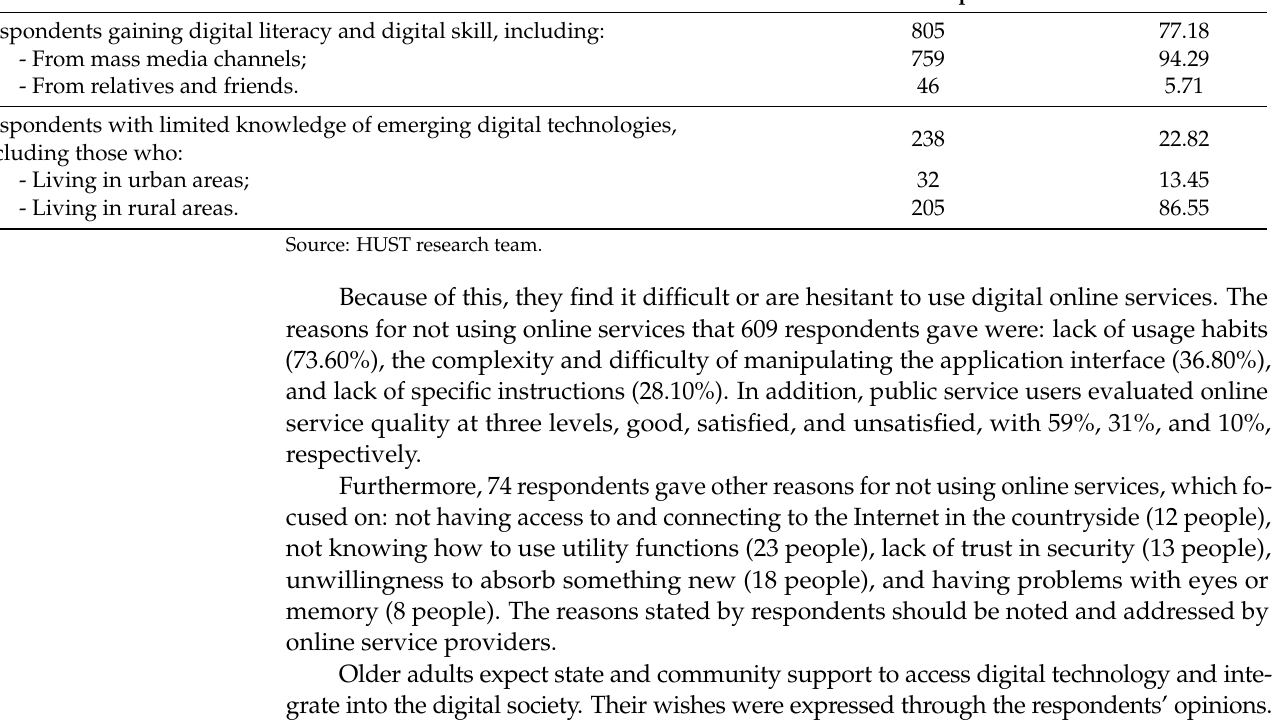
Table 6. Means of gaining digital literacy and digital skills among the